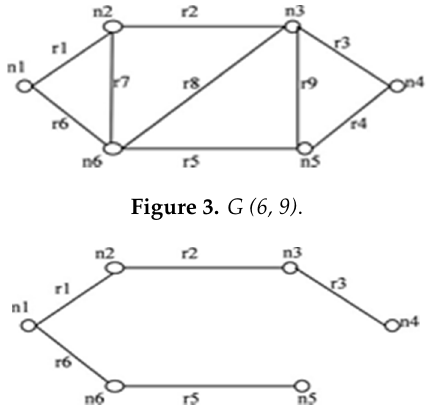
Figure 4. Initial spanning tree (IST) for G (6, 9).